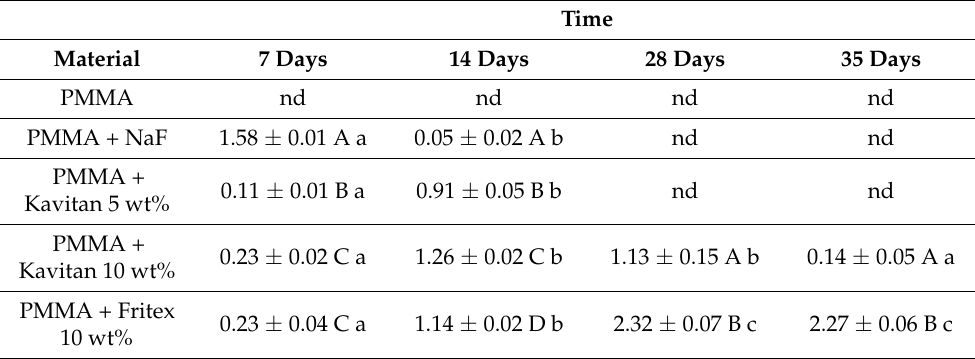
Table 3. Mean values ± SD of fluoride release [ µ g/cm 2 ].